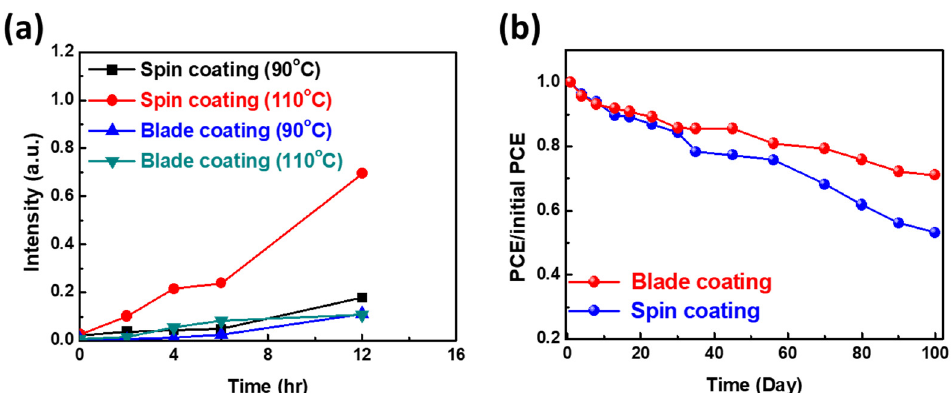
Figure 7. ( a ) Intensity ratio of PbI 2 formed in the MAPbI 3 perovskite film under thermal treatment and ( b ) long-term stability of PSCs fabricated by the two methods under ambient atmosphere (~45% relative humidity, 25 °C).